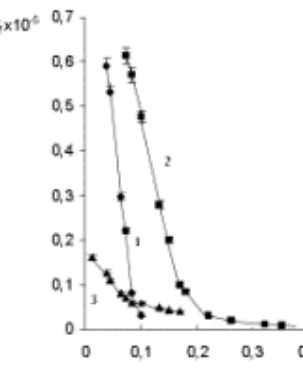
FIGURE 2. The binding curves of EtBr with ds-DNA obtained by Scatchard method from fluorescence (1) and absorbtion (2) spectrum at µ subtracting curve (1) from curve (2) and correspond to semi-intercalative complex of EtBr with